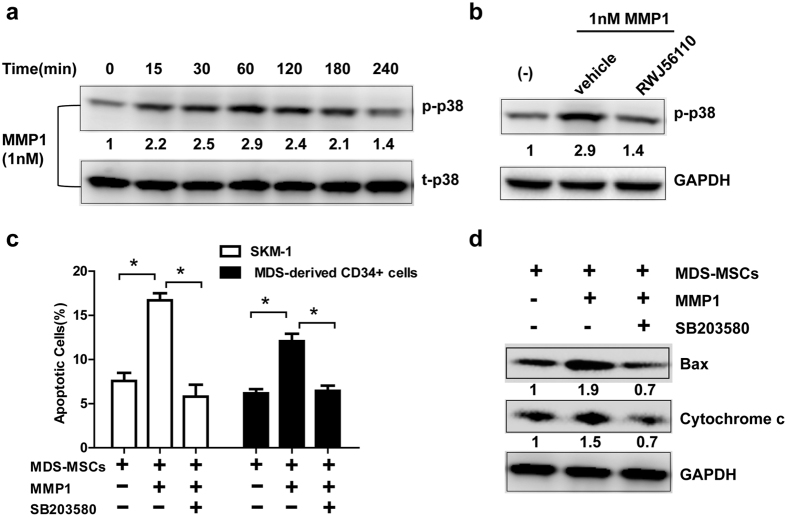
MMP1/PAR1 exerts apoptotic effect on MDS cells through the p38 MAPK pathway.(a) SKM-1 cells were starved overnight in serum free medium and stimulated with 1 nM MMP-1 over a period of 4 hours. Cell lysates were immunoblotted with anti-phospho-p38. Total p38 was used as the loading controls. Numbers below the band of p-p38 represented the relative expression levels of p-p38 at each time point compared with control according to gray scale analysis. (b) SKM-1 cells were pre-treated with 5 μM RWJ56110 and subsequently stimulated with 1 nM MMP-1. Cell lysates were immunoblotted with anti-phospho-p38. GAPDH was used as the loading control. Numbers below the band of p-p38 represented the relative expression levels of p-p38 of each group compared with control according to gray scale analysis. (c) In the MDS-MSCs and MDS cells co-culture system, 1 nM MMP1 was added with or without pre-treatment of p38 inhibitor SB203580 (10 μM). The percentage of apoptotic MDS cells was assessed by Annexin V/PI dual staining. (d) In the MDS-MSCs and SKM-1 cells co-culture system, 1 nM MMP1 was added with or without pre-treatment of the p38 inhibitor SB203580 (10 μM). Cell lysates of SKM-1 were immunoblotted with anti-Bax and anti-Cytochrome c. GAPDH was used as the loading control. Numbers below the band of Bax and cytochrome c represented the relative expression levels of Bax and cytochrome c of each group compared with control according to gray scale analysis. (Data represent the mean ± SEM from at least three independent experiments. *P < 0.05).